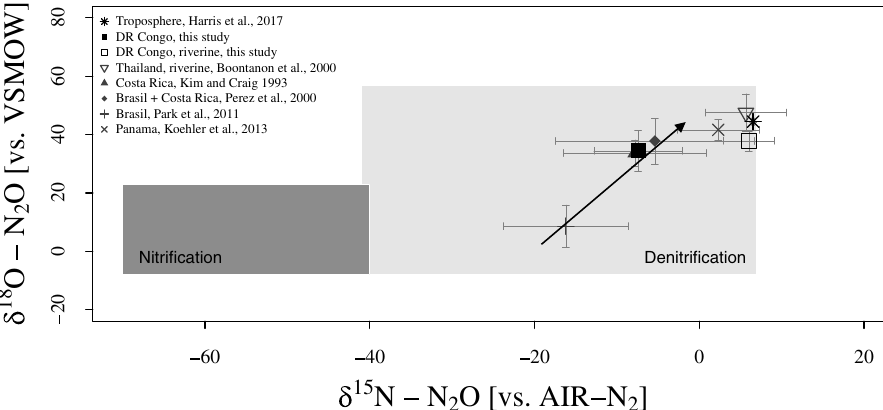
Fig. 3 Stable isotope signatures of tropical forest soil N 2 O fl uxes. Isotope map of δ 18 O vs. δ 15 N adapted from Koba et al. (2009) 33 of tropical forest soil N 2 O fl uxes 35,79 – 81 and riverine N 2 O 82 derived from literature and this study with overall site medians given in ‰ . Note, values from Koehler et al. (2012) and Pérez et al. (2000) are fully or partly from soil pore air measurements. Arrow indicates empirical reduction vector with the ratio of 2.4 ( ε 18 O/ ε 15 N) 33 . Rectangles depict literature ranges of δ 18 O vs. δ 15 N for the N 2 O production from nitri fi cation and denitri fi cation. Asterisk (*) represents isotope composition of tropospheric air as reference 44 . Error bars indicate standard